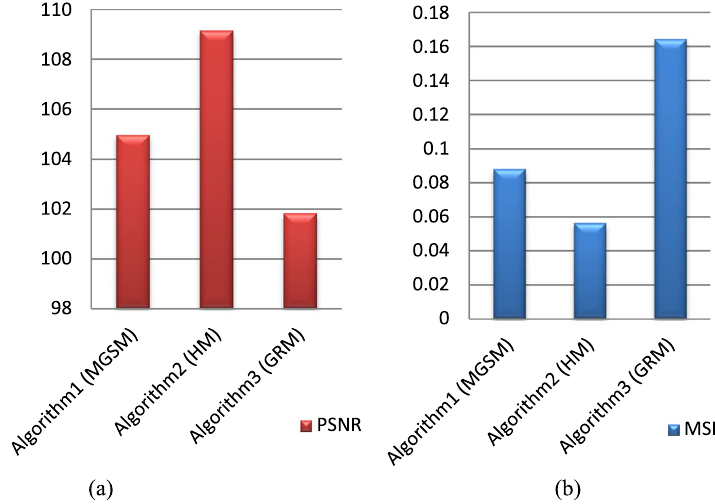
Fig. 3 The average values a PSNR and b MSE of the reconstructed signals using Tchebichef moments with Gram–Schmidt, Householder, and Given Rotations methods